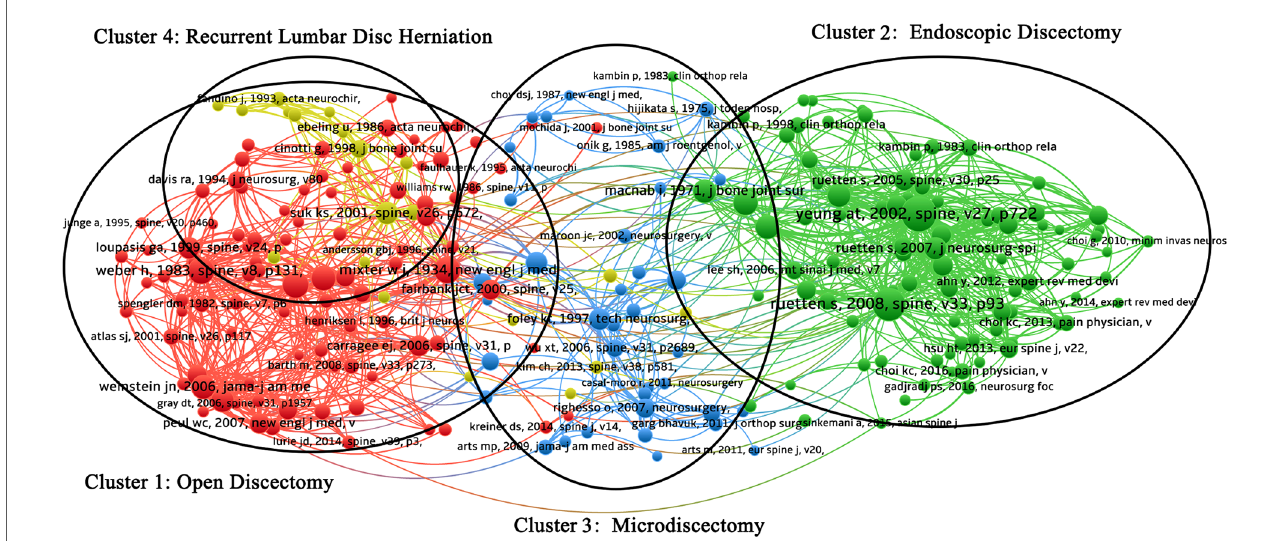
FIGURE 4 Mapping of citation network related to discectomy. Given the large number of cited references, this study only selected papers cited more than 20 times for analysis and a total 240 papers were included. A line between two points means that both were cited in one paper. Points are divided into four clusters: clusters one (red) are papers related to open lumbar discectomy; clusters two (green) are papers related to endoscopic discectomy; cluster three (blue) contains papers related to microdiscectomy and microendoscopic discectomy; and cluster four (yellow) contains papers related to recurrent lumbar disc